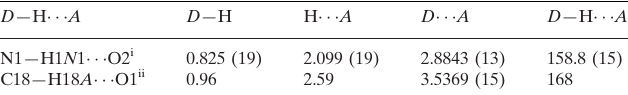
Hydrogen-bond geometry (A˚ , (cid:3)